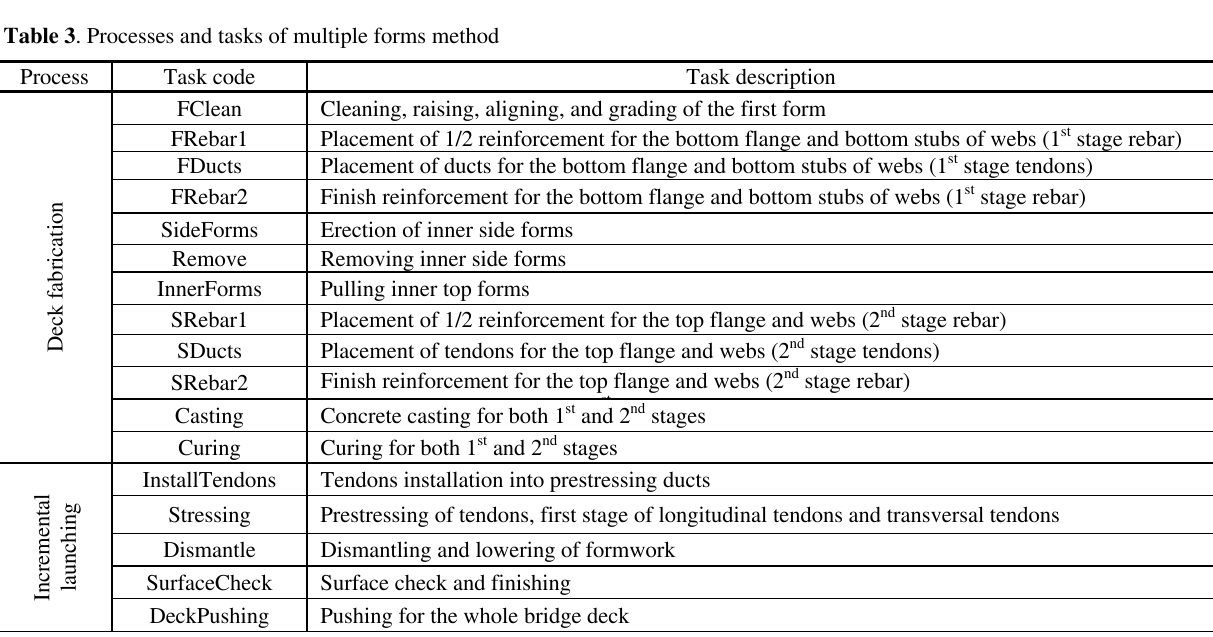
Fig 4 . Segments fabrication by multiple forms method